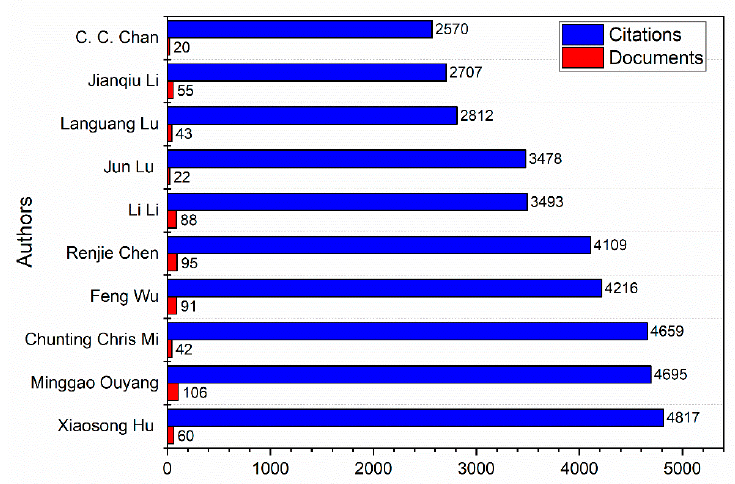
Figure 3. Distribution of the top 10 authors based on the number of citations and documents.